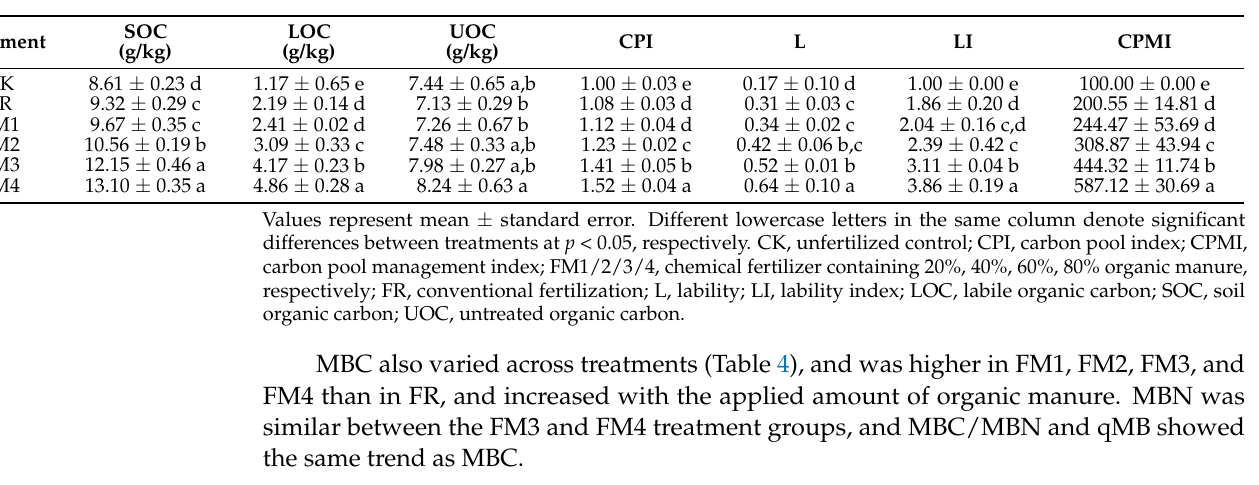
Figure 1. Soil enzyme activities under different organic manure treatment conditions. Different lowercase letters in the same box denote significant differences at p < 0.05, respectively; short horizontal lines at the top of each column denote standard error. Table 3. Change in soil organic carbon fraction and carbon pool management index under different